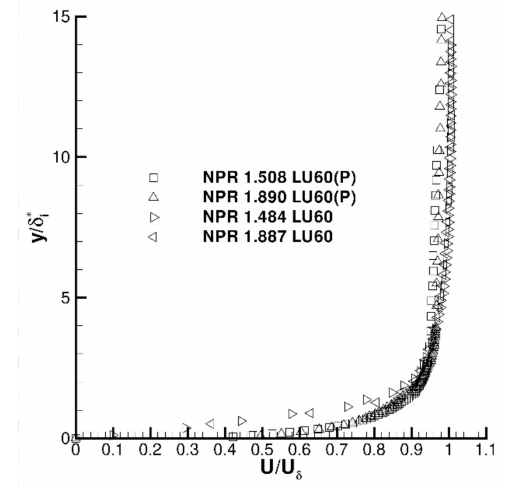
Figure 14. LU60/LU60P nozzle exit axial velocity